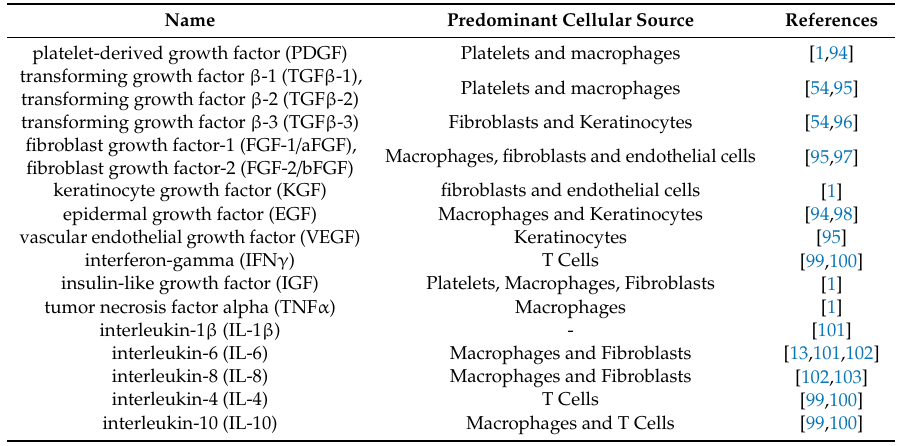
Table 1. Cytokines and growth factor (GF) of current therapeutic importance in the modulation of wound repair and scarring